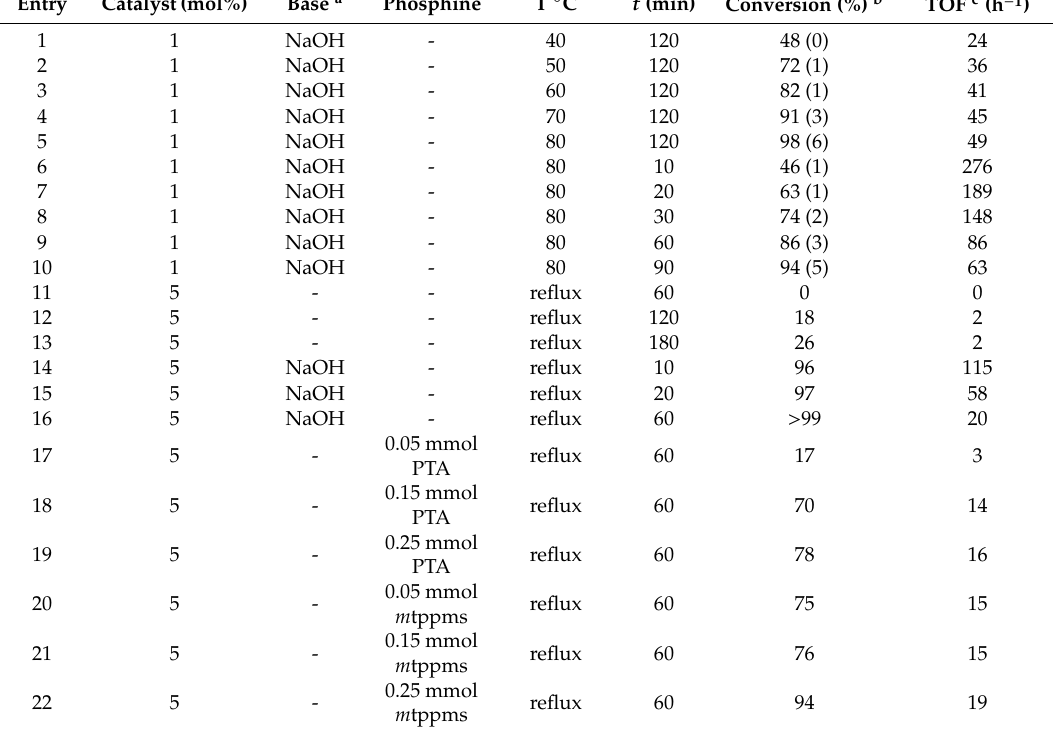
Table 5. The e ff ect of various reaction parameters on the hydration of benzonitrile catalyzed by [RhCl(cod)(IMes)] ( 1